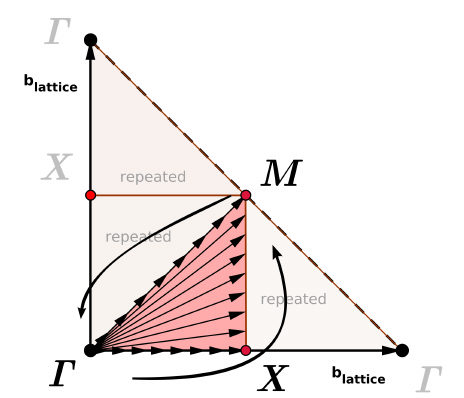
Figure 3. Irreducible Brillouin zone (pink area) of the square pattern shown in Figure 2. The arrows represent the k-vector projections in the plane of the PhC slab periodicity. For each k-vector, the allowed frequencies are calculated (there will be one frequency for each mode), obtaining the band diagram of the system (see Figure 4). The light pink areas, marked as “repeated”, are just a replica of a rotated and translated irreducible zone; therefore, no additional information can be extracted examining this areas.